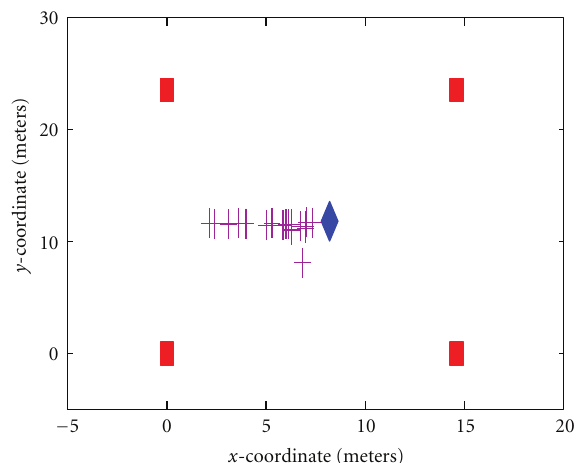
Figure 10: Node deployment during March 2010 pool test. The transmitters are denoted by squares, and the receiver is denoted by the diamond. The scattered plus signs are the estimates by the least- squares method.